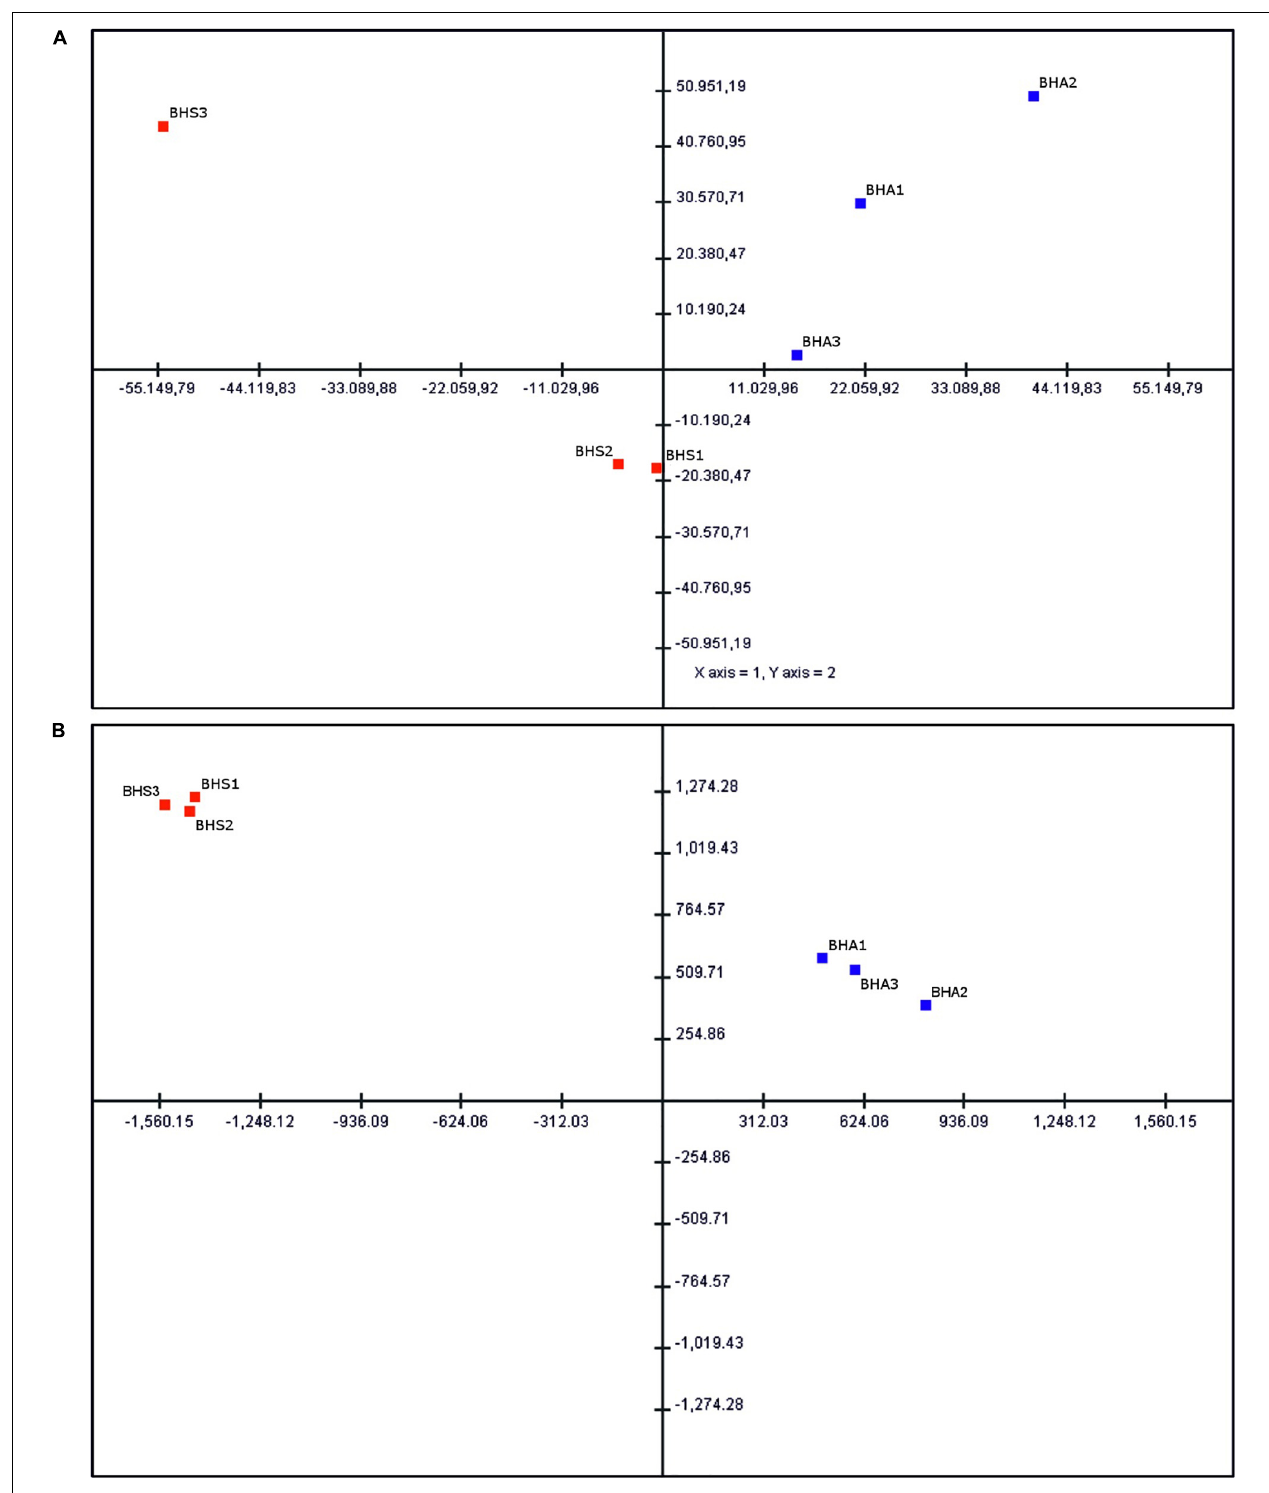
FIGURE 2 | Principal component analysis (PCA) of ovule-expressed transcripts. (A) Statistical analysis performed by using all expressed transcripts. The percentage variation explained by the two axes is about 44%. (B) Statistical analysis performed by using DEGs and phenotype-specific transcripts. The percentage variation explained by the two axes is about 96%. Sexual samples (BHS1-3) are shown as red squares, while aposporous apomictic samples (BHA1-3) are shown as blue squares.